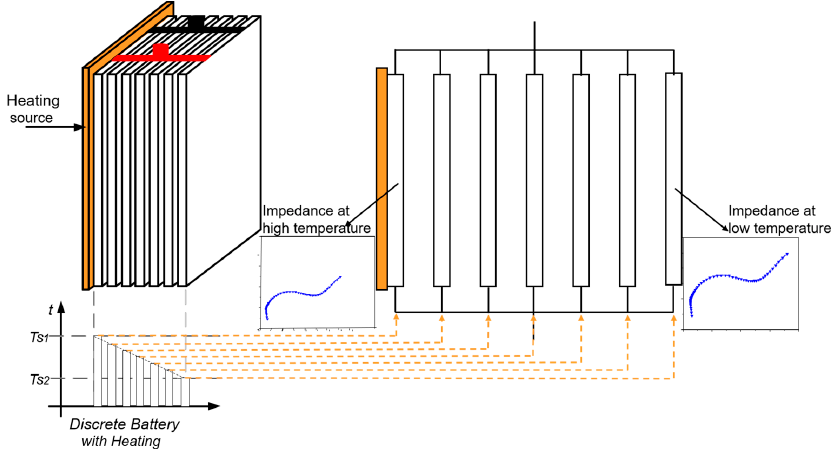
Figure 4. Diagram of battery discretization with a heating source.